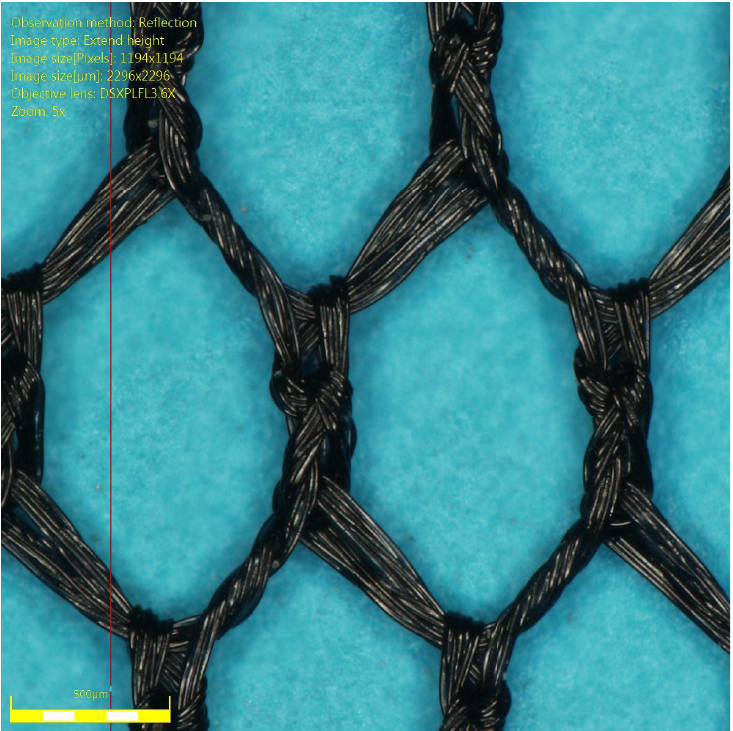
Figure 1. An original spacer used in this study, showing small variance of the residence time distri- bution and high mass transfer [10 –